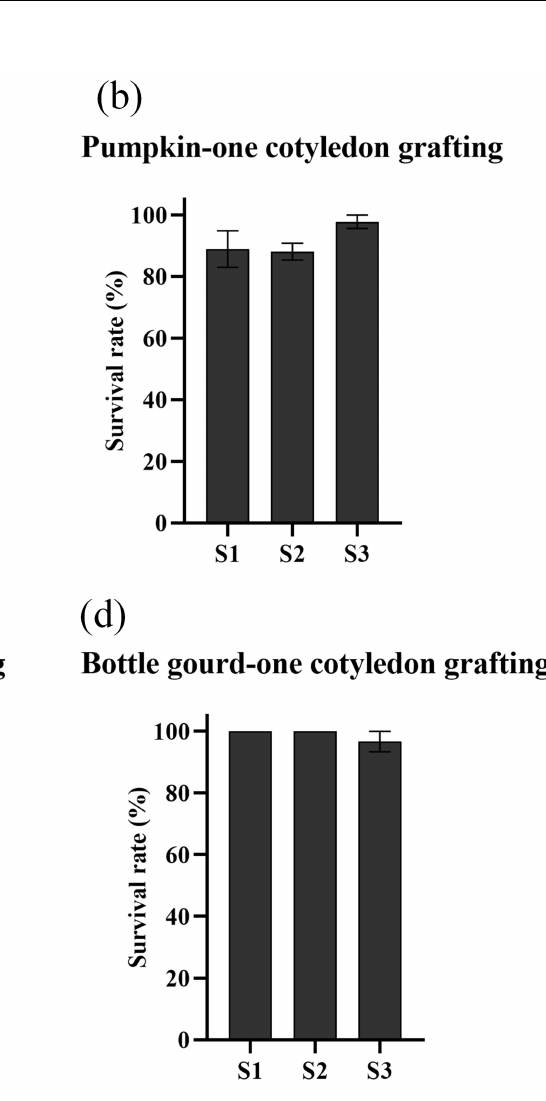
Figure 3. Graft survival rate at day 14 after grafting ( n = 3). T1 and S1, new “hole insertion grafting” ( a , c ) and “one cotyledon grafting” ( b , d ), respectively, without the regrown rootstock removal; T2 and S2, traditional “hole insertion grafting” ( a , c ) and “one cotyledon grafting” ( b , d ), respectively, with manual regrown rootstock removal 3 times; T3 and S3, traditional “hole insertion grafting” ( a , c ) and “one cotyledon grafting” ( b , d ), respectively, without the regrown rootstock